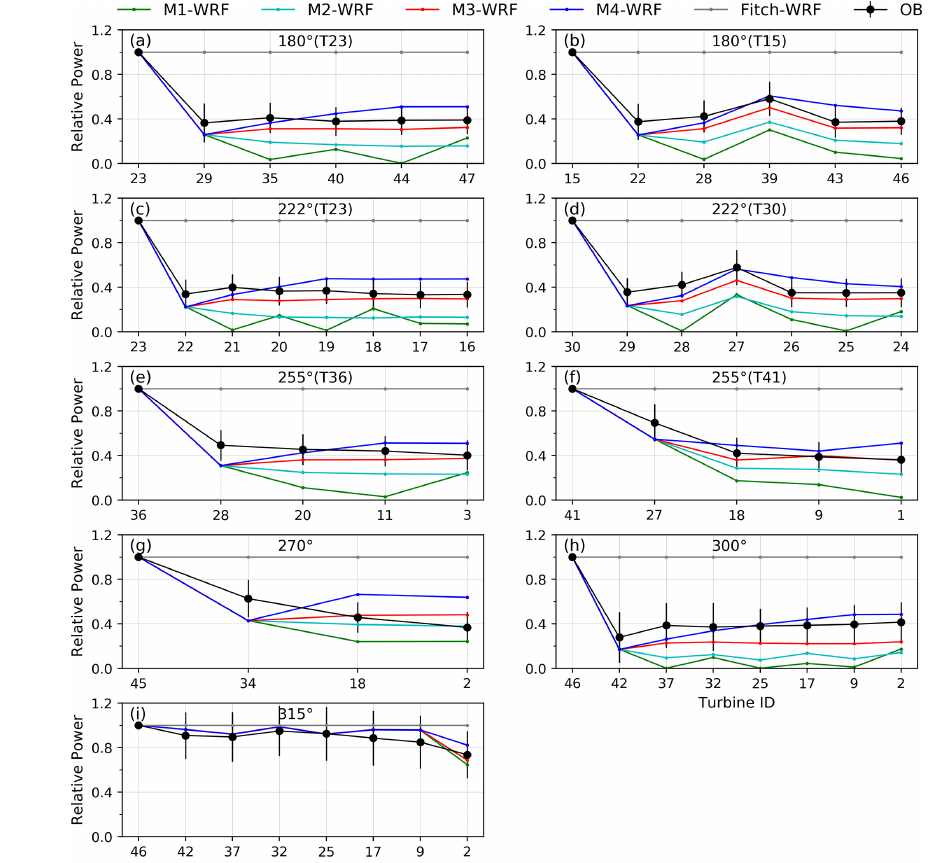
Figure 4. Lillgrund (single cell): relative power from observations and from the Jensen wind farm parameterization with the four wake superposition methods, M1–M4, along the directions of alignment (a–h) and the direction of non-alignment (i) . The black circles represent the mean observed relative power, and the bars are 1 standard deviation. The simulation results from the Jensen parameterization, and the observations are averaged over ± 2 . 5 ◦ ; the bin size for the observations is 0.5 ◦ . The wind direction averaging was not applied to the results from the Fitch parameterization because it is insensitive to wind